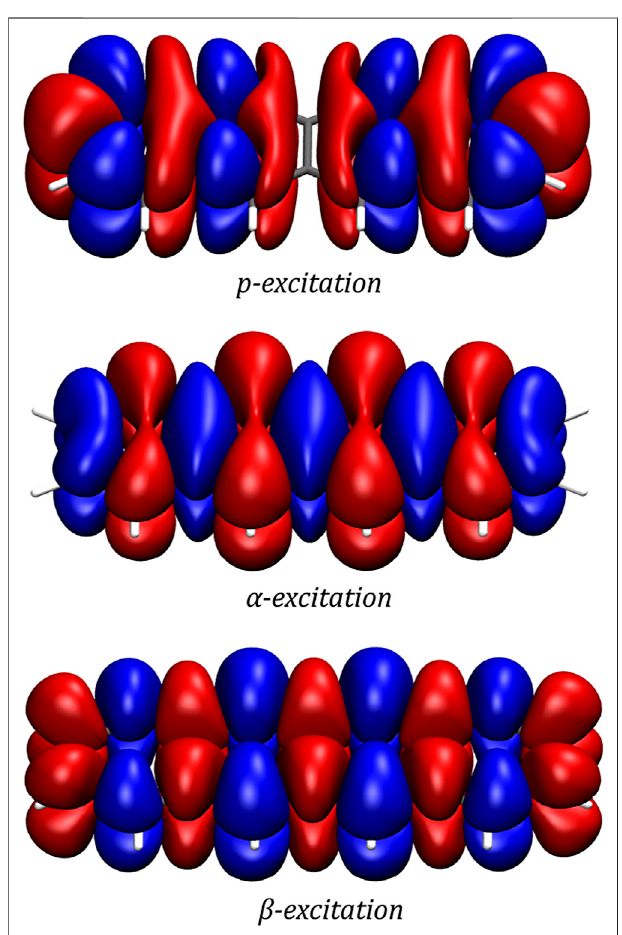
FIGURE 3 | Transition densities of the p -, α - and β -excitations as generated by a two-component CD-ev GW /BSE@CAM-B3LYP calculation. The plots were generated with VMD using an isovalue of 0.0001 a − 3 0 for the p - excitation and 0.0002 a − 3 0 for the α - and β -excitations. The colour blue indicates a loss while red indicates a gain of electron density.